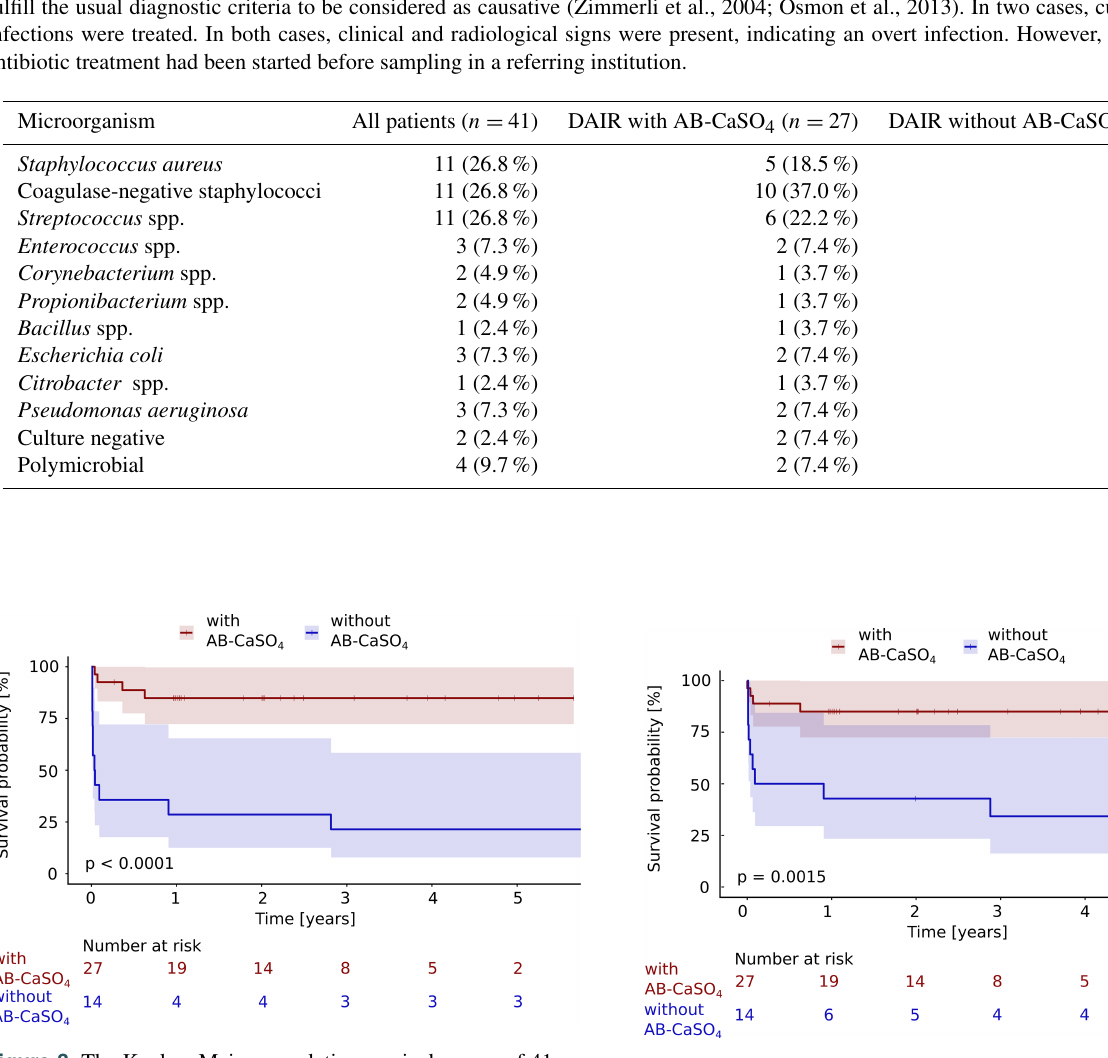
Figure 4. The Kaplan–Meier cumulative survival curves of the 41 patients with PJI of the hip treated by DAIR procedure are shown and are stratified by treatment with and without local application of antibiotics with CaSO 4 as the carrier material. The end point was defined as any reoperation for component exchange. For this analy- sis, repeat DAIR was not considered as a failure. The survival data were compared using the log rank test. A significantly ( p = 0 . 0015) longer infection-free cumulative survival could be observed in the intervention group compared to the control group. The confidence interval indicated corresponds to a 95% confidence interval. The Cox proportional hazard ratio over the whole study period was 5.6 (95% CI 1.7–18.2) for a revision with component exchange, favor- ing the addition of AB-CaSO 4